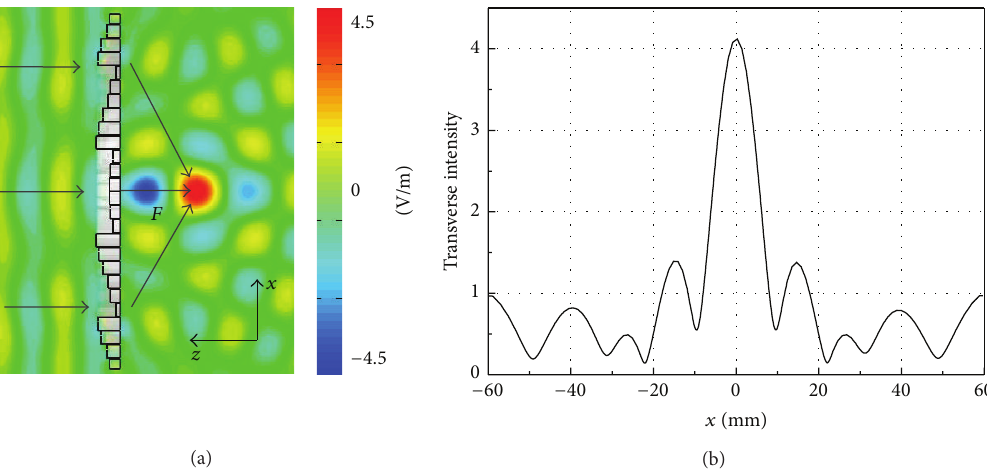
Figure 5: (a) The time snapshot of the steady-state electric field in the 𝑥 - 𝑧 plane; (b) intensity distribution of the steady-state electric field along the 𝑥 -axis in the focal plane. The operating frequency of the incident plane waves is 16 GHz.